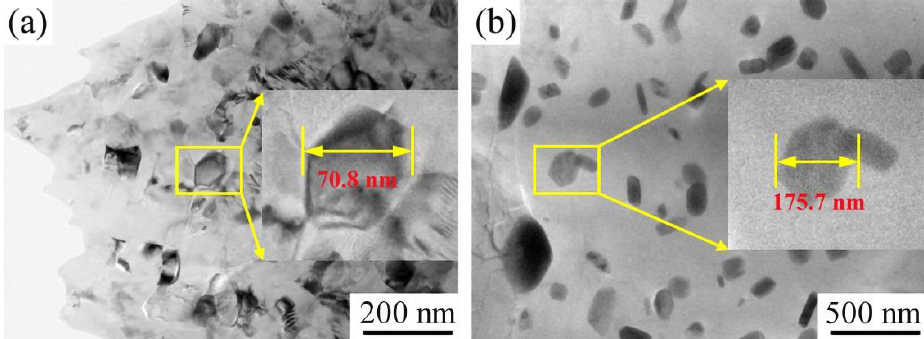
Figure 15. TEM figures of Al-Zn-Mg-Cu alloy: (a) 0.1s-1,673K, (b) 10s-1,673K . Fi . After isothermal, experimental compression, the softening mechanism is mainly DRV accompanied by a small part of DRX. Similarly, the deformation mechanism of 5xxx Al alloy is DRV, while the volume fraction of DRX increases significantly with in-